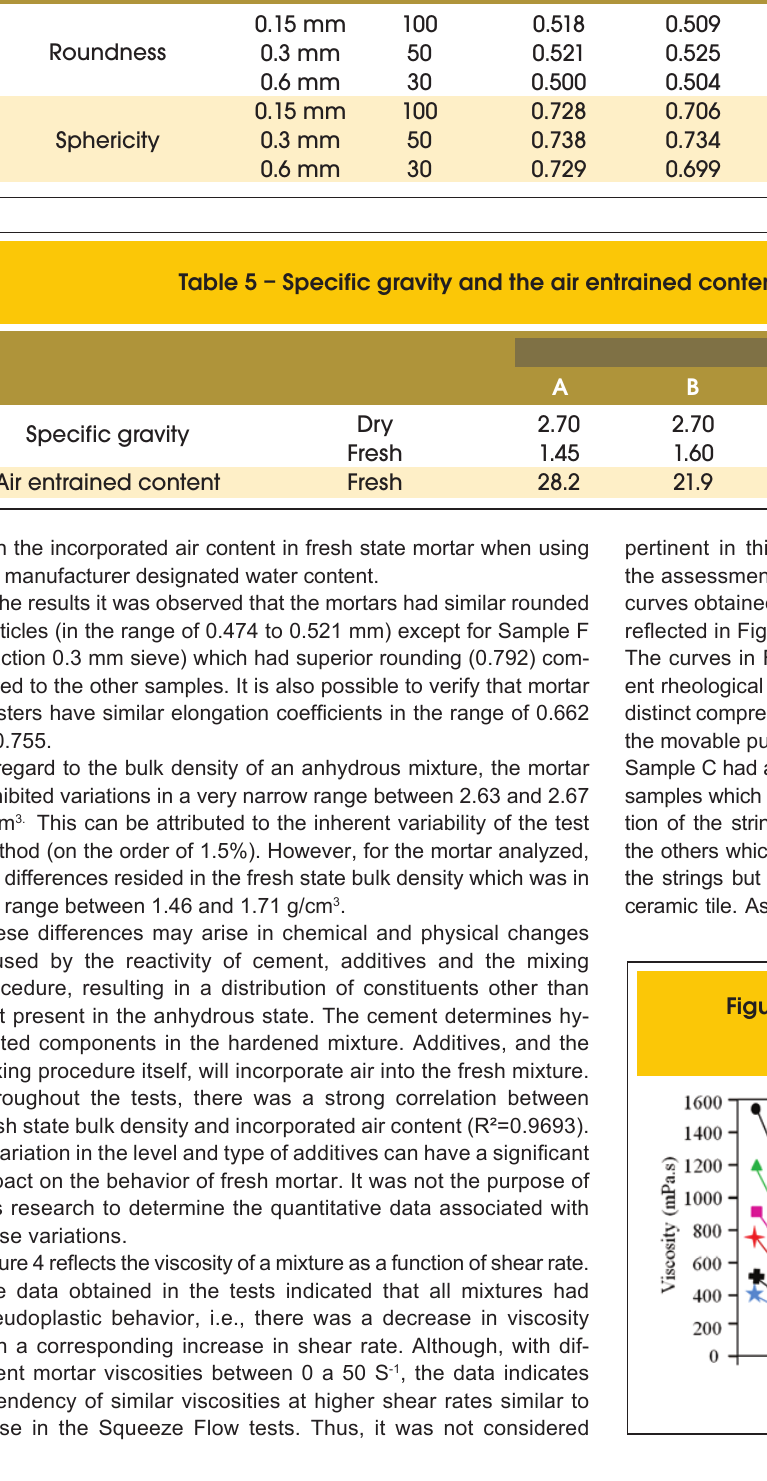
Adhesive mortarSieve